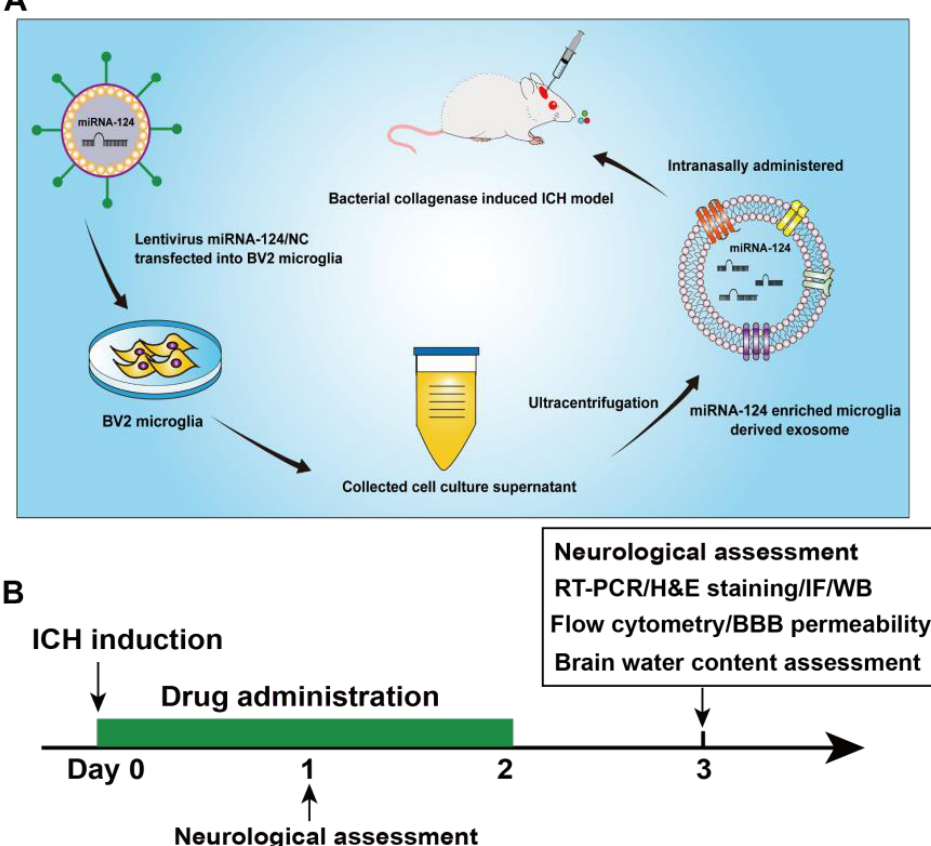
Figure 2. Schematic of the experimental design. ( A , B ) The schematic shows the experimental process, including exosome preparation, animal model establishment, and exosome administration.